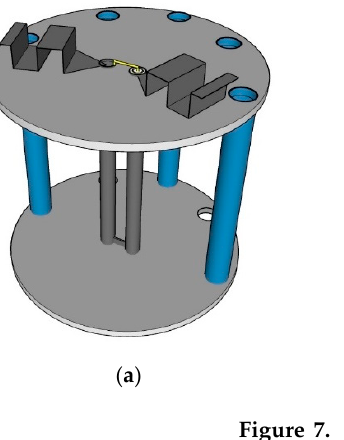
Figure 8. Simulated impedance bandwidth (| S 11 | ≤ − 10 dB) of the fi rst-, second-, and third- generation antenna schemes.